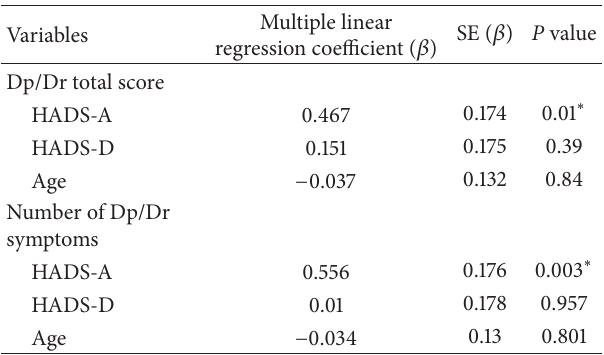
Table 4: Multiple linear regression analysis of predictors for Dp/Dr of vestibular